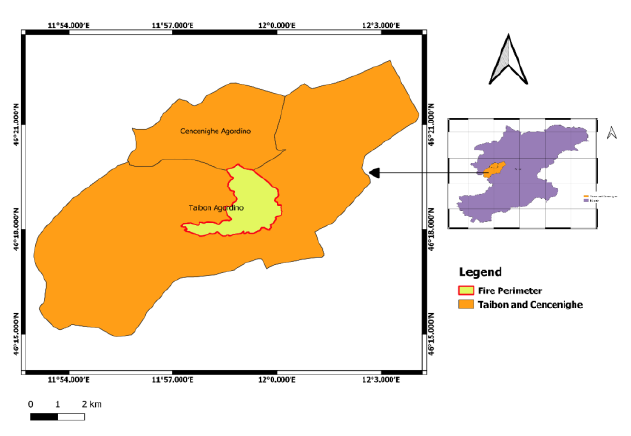
Figure 1. Location of the study area in Taibon Agordino, Belluno Province, Italy Figure 2. Samples of ground pictures of the various fire